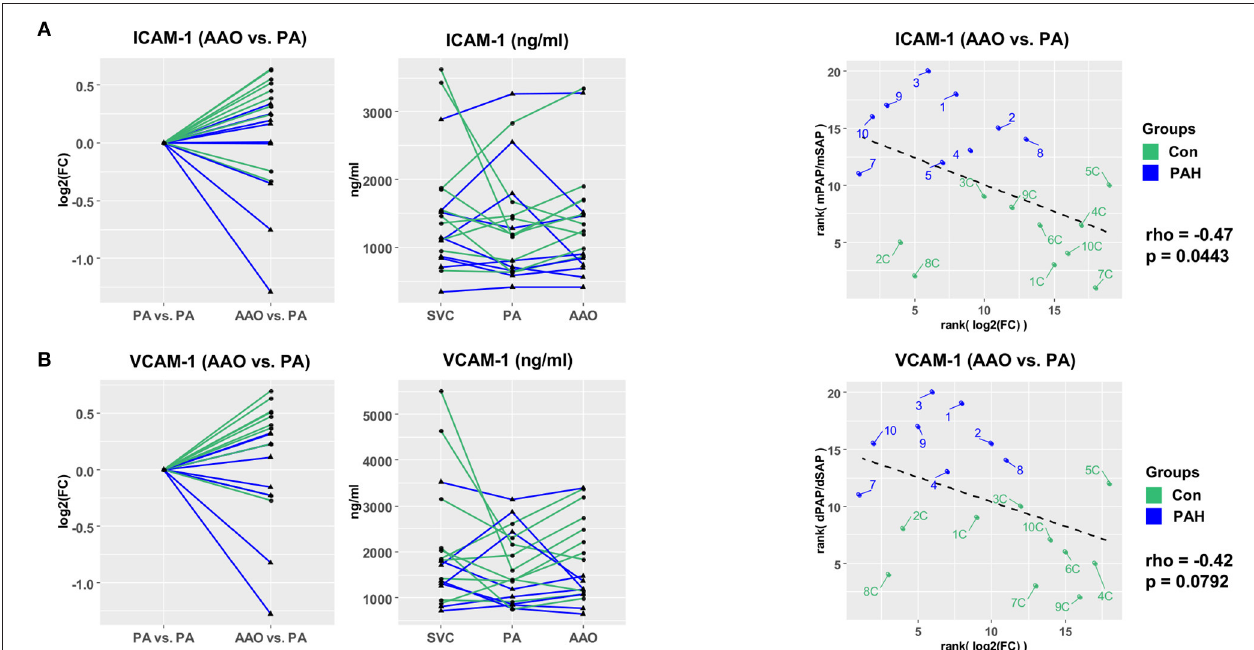
FIGURE 3 | Vascular injury markers ICAM-1 and VCAM-1 have differential transpulmonary gradients in pediatric PH vs. non-PH controls. (A) Step-down in PAH (FC = 0.86) and step-up in controls (FC = 1.21) for ICAM-1 levels. (B) Step-down in PAH (FC = 0.85) and step-up in controls (FC = 1.28) for VCAM-1. For transpulmonary gradient analysis, we used Wald χ 2 test (linear mixed effects models). For correlation analysis, we used Spearman’s rho (A,B) . ICAM-1 and VCAM-1 had moderate negative correlation with hemodynamic variables (mPAP/mSAP; dPAP/dSAP). AAO, ascending aorta; dPAP, diastolic pulmonary arterial pressure; dSAP, diastolic systemic arterial pressure; ICAM-1, intercellular adhesion molecule 1; mPAP, mean pulmonary arterial pressure; mSAP, mean systemic arterial pressure; PA, pulmonary artery; PH, pulmonary hypertension; SVC, superior vena cava; VCAM-1, vascular cell adhesion molecule